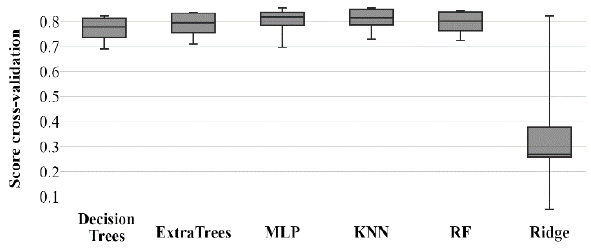
Figure 4. Box and whiskers plot with the means and standard deviations obtained using 10-folds cross-validation for the different ML methods